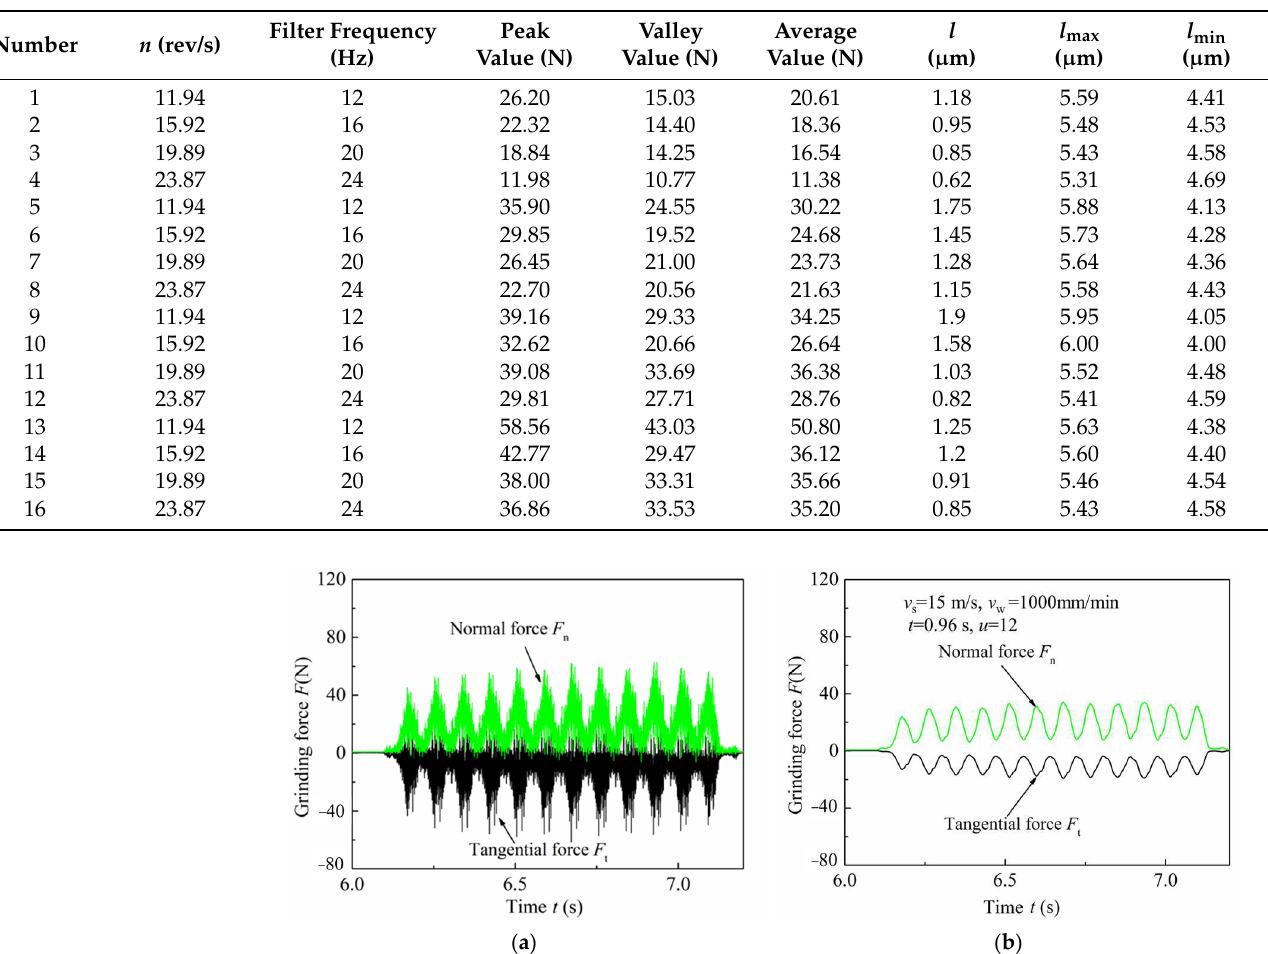
Table 5. Relationship between grinding forces and actual grinding depth.